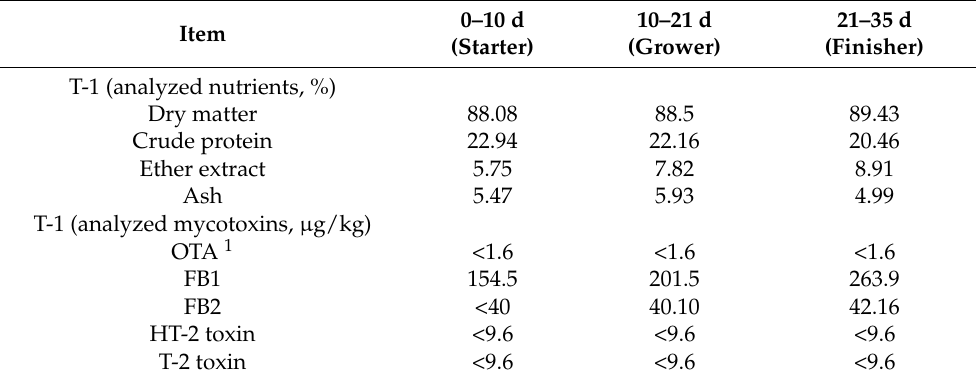
Table 2. Analyzed nutrients (%) and mycotoxins ( µ g/kg) in experimental diets.